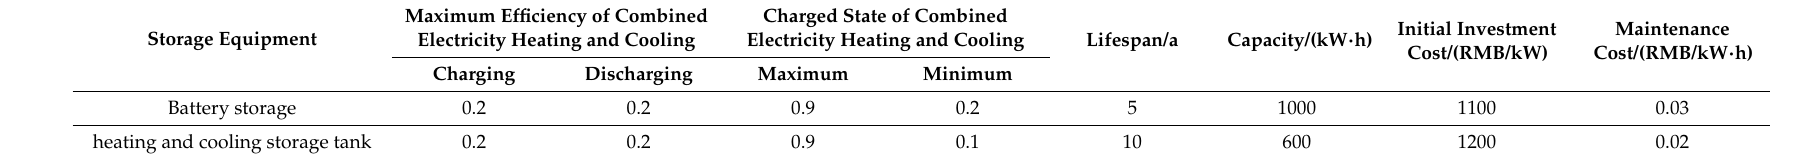
Table 4. Storage equipment parameters of the micro energy grid.